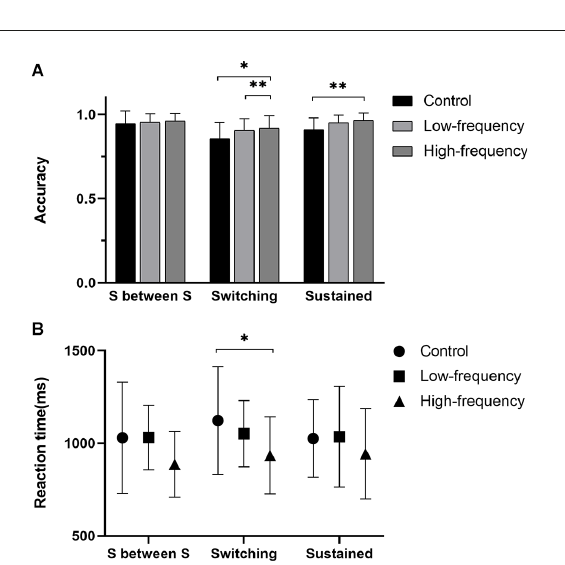
FIGURE3 Results of the Switching task. (A) The accuracy of three blocks, (B) the reaction time of three blocks. S between S for Sustained between Switching block. ∗ Statistically significant with P < 0.05, ∗∗ statistically significant with P <